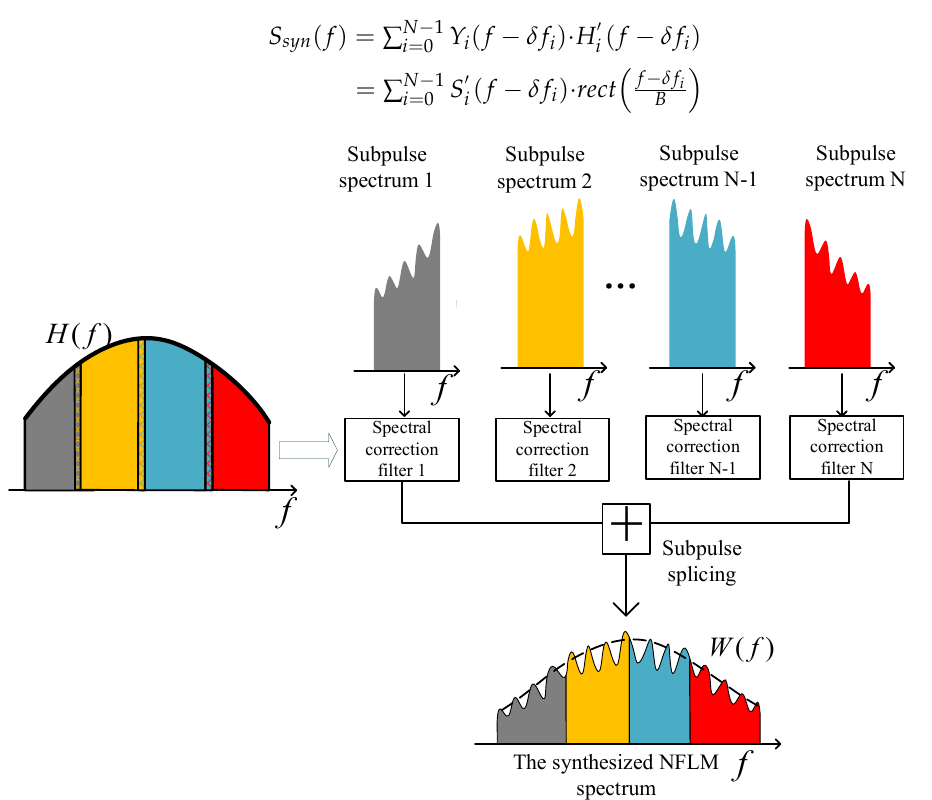
Up-sampling, spectrum displacement, and subpulse splicing are performed on the output of the subpulse spectral correction filter, respectively, and the synthesized NLFM spectrum is shown in Equation (18) and Figure 7.